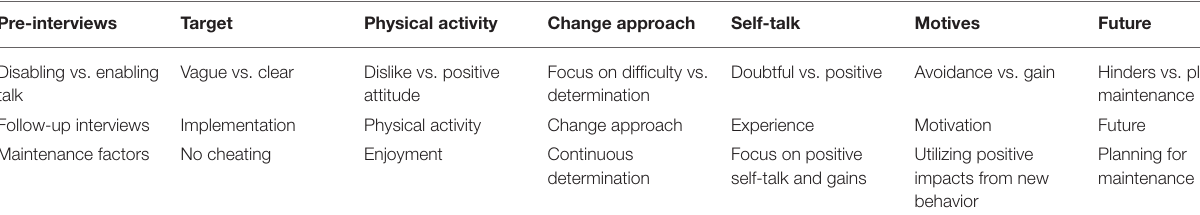
TABLE 6 | Summary of qualitative results.